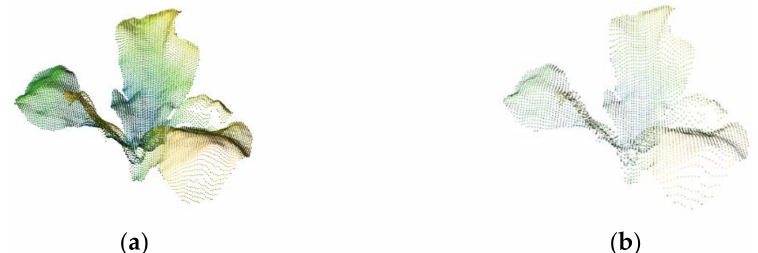
Figure 3. ( a ) Point cloud before downsampling. ( b ) Point cloud after downsampling.